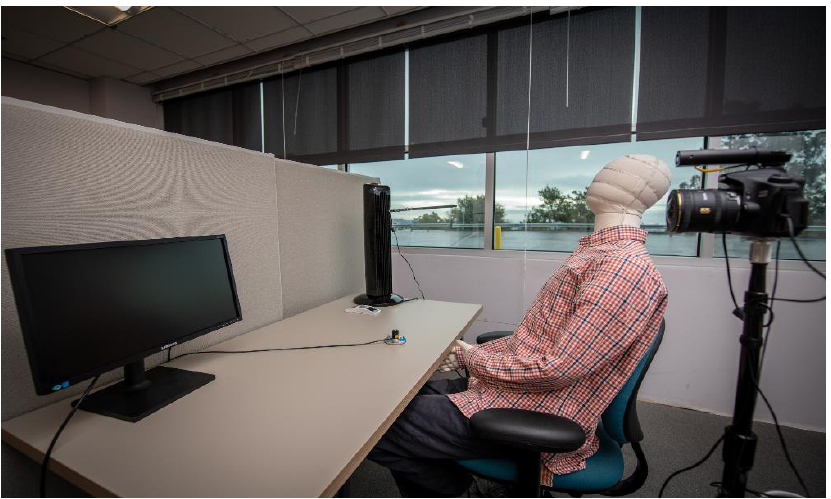
Figure 4. Photograph of window-adjacent workstation in test cell. This photograph shows the desktop illuminance sensor, as well as the HDR camera for sensing glare in the occupant field of view. The CorePlus automated shades are in use and, likely due to the cloudy sky condition, are retracted halfway to allow daylight into the space.